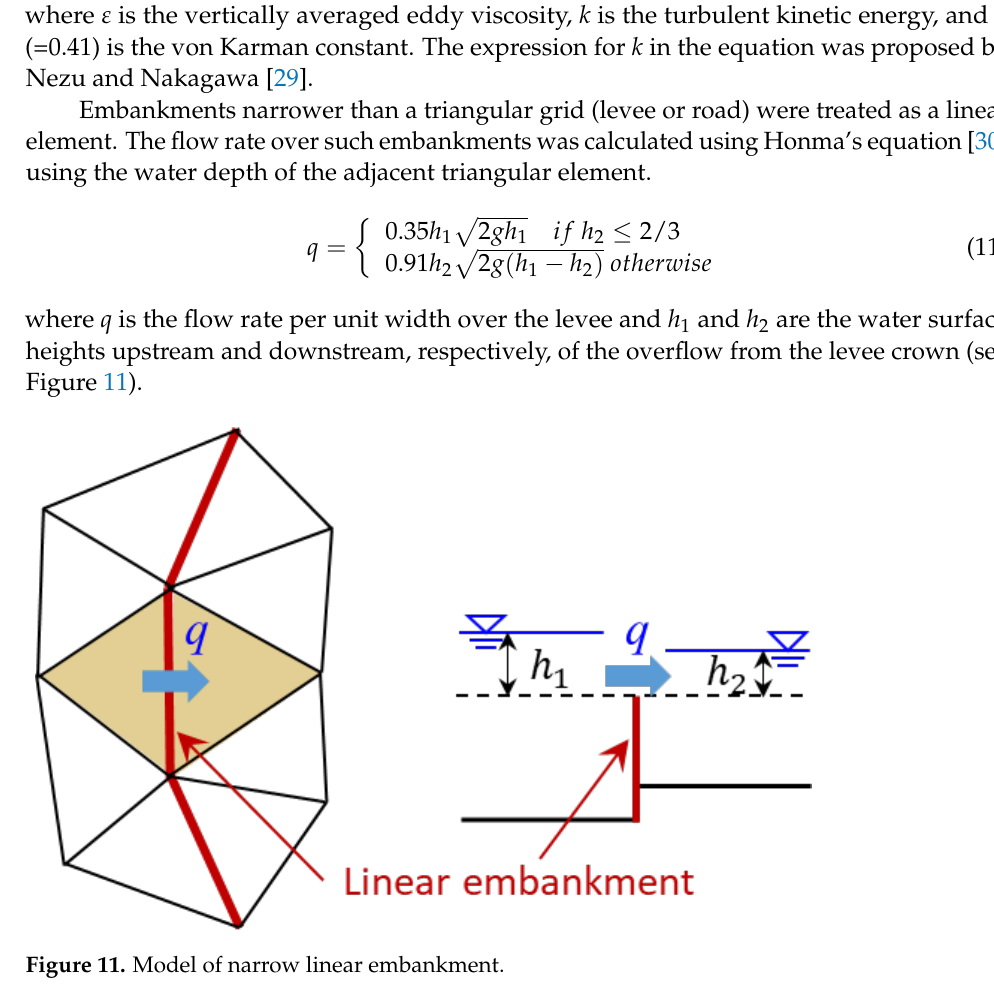
Figure 11. Model of narrow linear embankment.